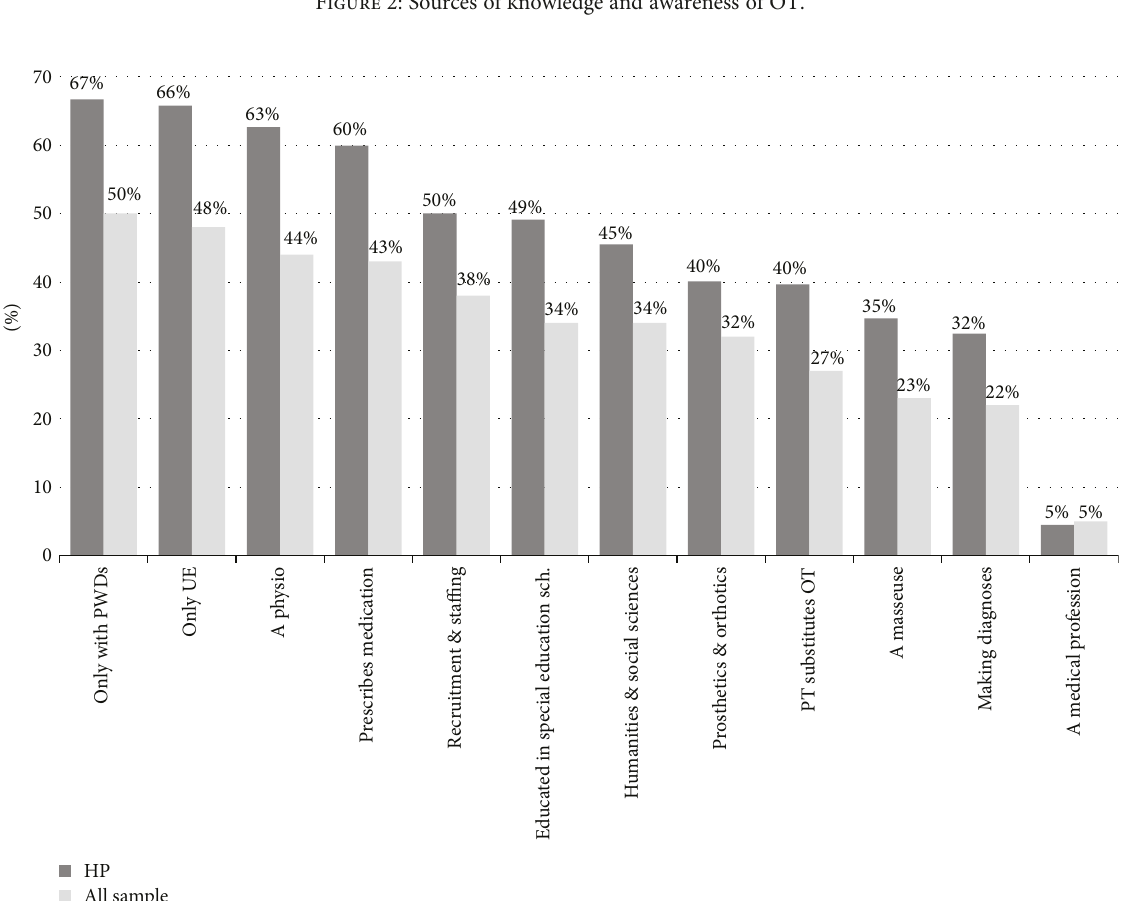
Figure 3: Misconceptions about OT in healthcare personnel subgroup (HP) and the whole